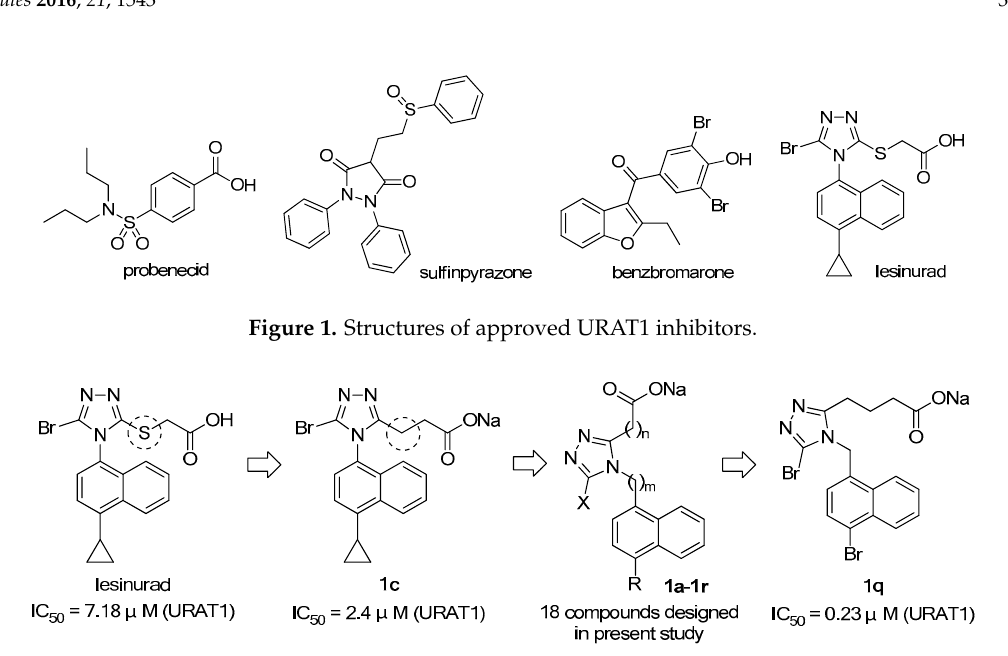
Figure 2. Design of URAT1 inhibitors in present study and discovery of 1q .